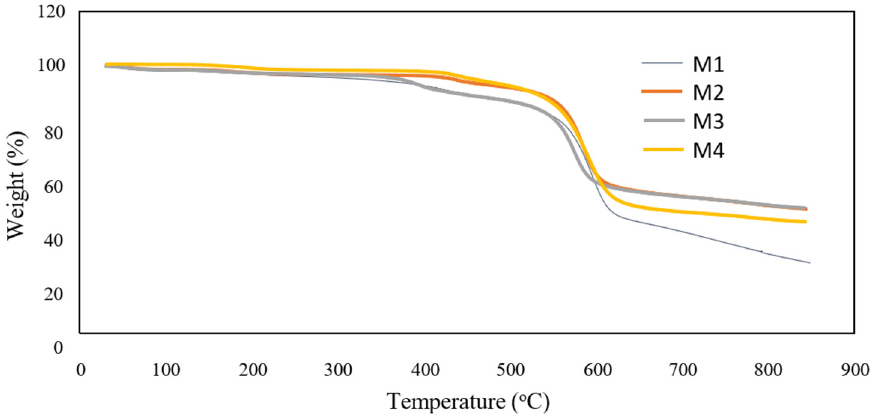
Figure 5. TGA analysis for the membranes.